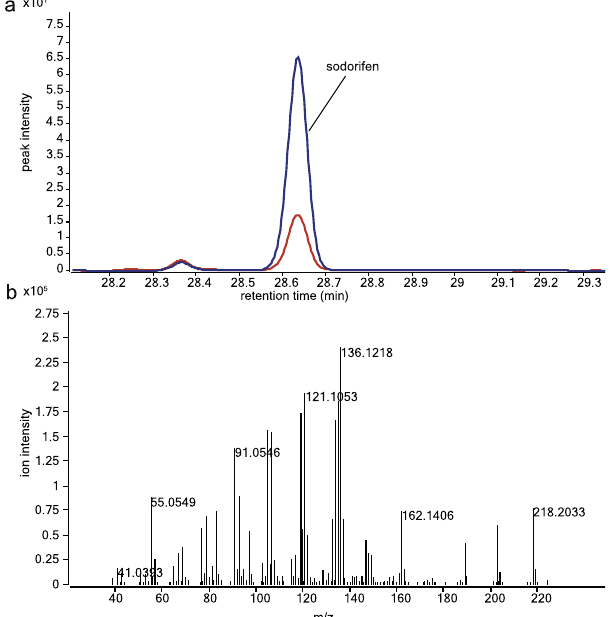
Figure 5. Volatile spectra of the sodorifen peak at RT 28.6 produced by S. plymuthica PRI-2C exposed to fungal VOCs (blue) and by S. plyumthica without exposure to fungal VOCs (red) ( a ) and mass spectrum of sodorifen produced by S. plymuthica PRI-2C ( b ).